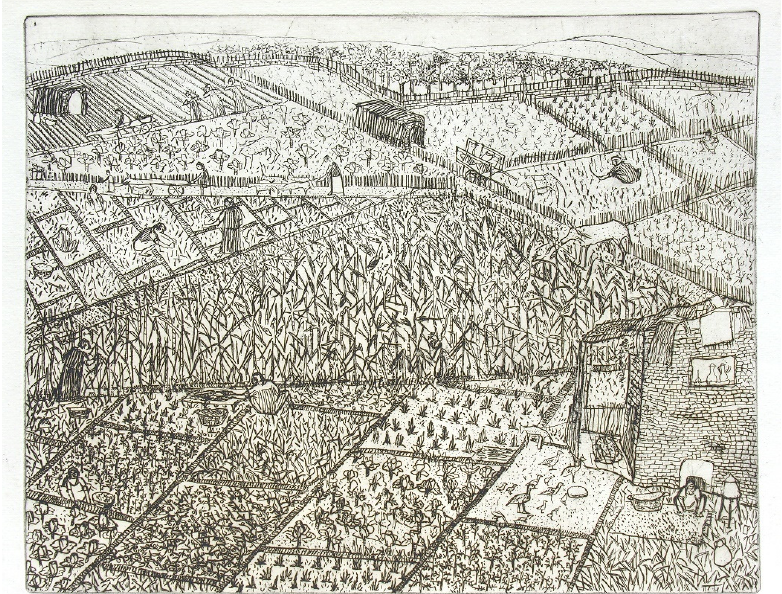
Figure 11. Menhat Helmy, Agricultural Production (undated, circa 1956–1966). Etching. Courtesy of estate of Menhat Helmy. Note: According to Al-Razzaz (2006), this may have been entitled al-intaj al-zira`a (Agricultural Production).